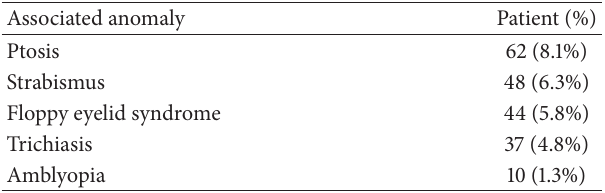
Table 3: Associated ocular disease in epiblepharon patients.